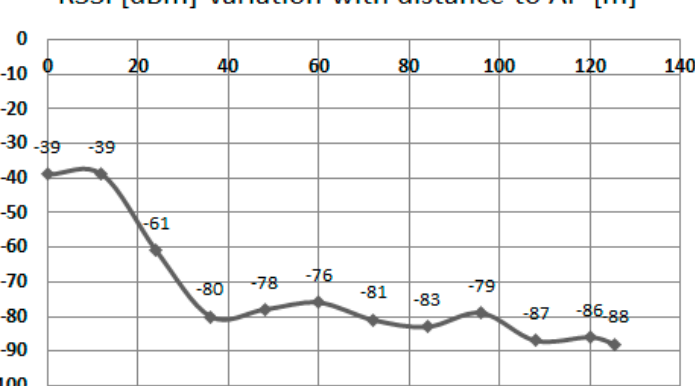
Figure 1. Outdoor variation of RSSI with distance, open field (from previous work, source: [17]).